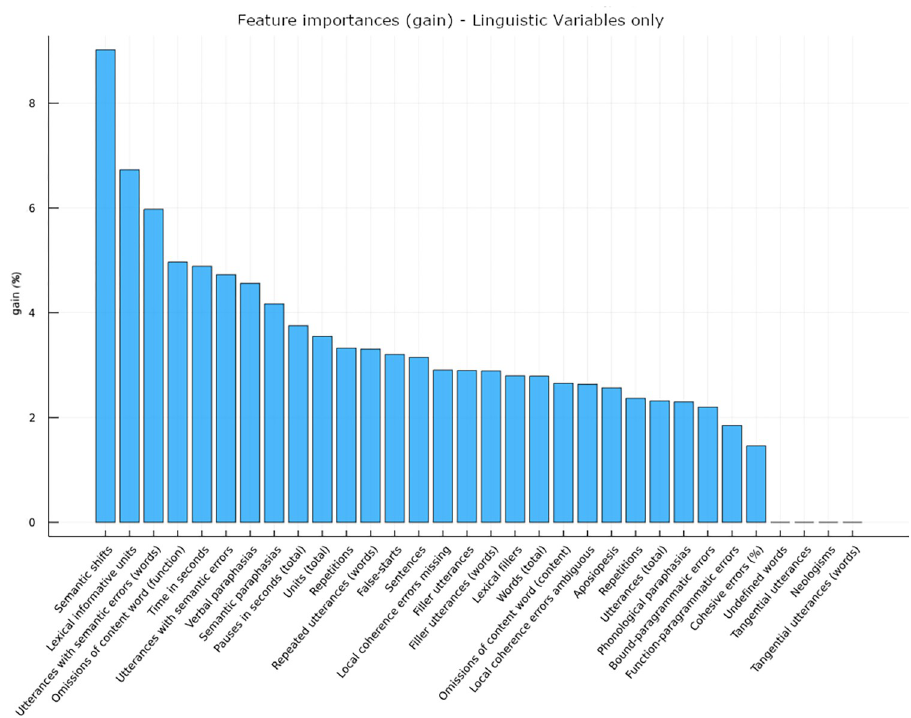
Fig 1. Language production variables feature gain.